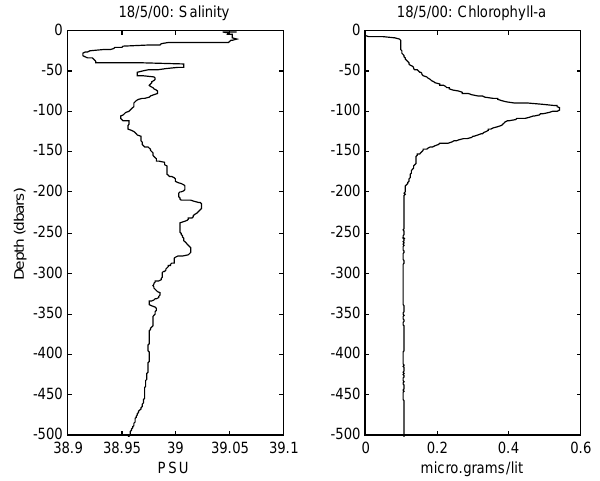
Fig. 9. Salinity and chlorophyll-a profiles at the M3A site on 18 May 2000. Data were collected during a regular maintenance cruise of R/V Filia using a SBE-25